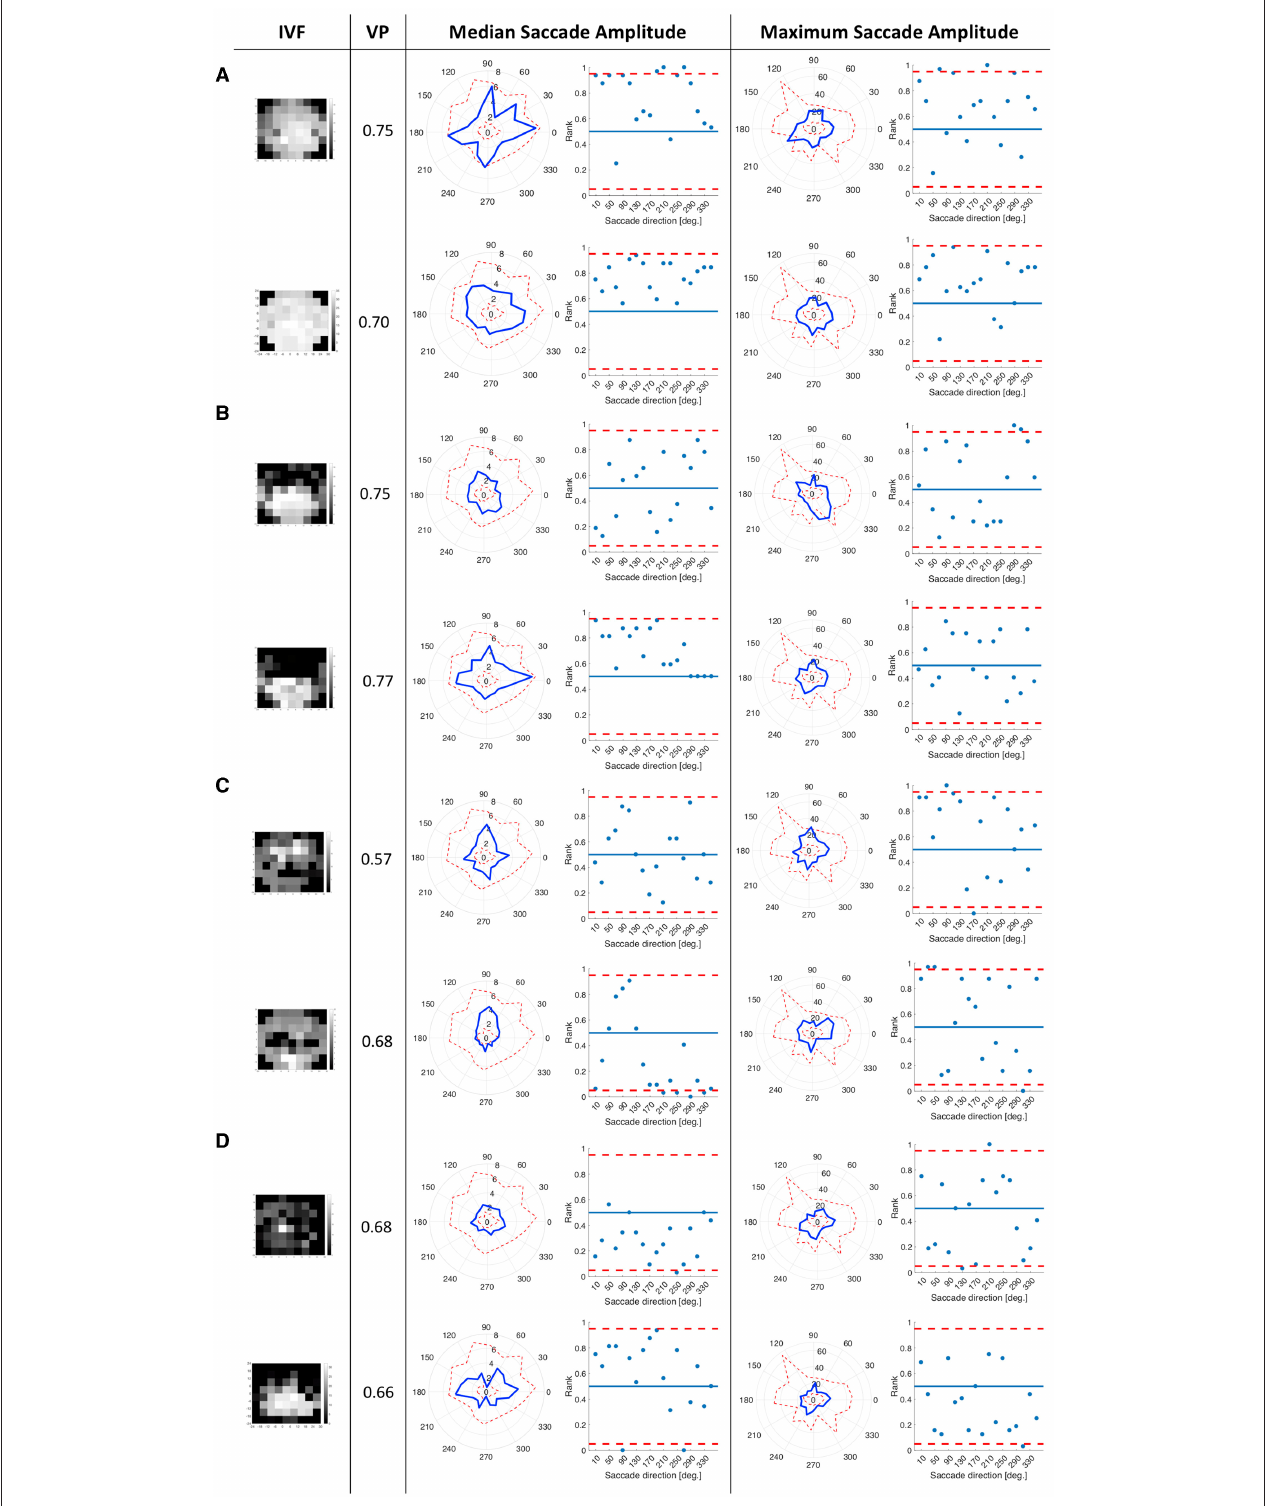
FIGURE 10 | The first figure shows the state of the IVF of each patient, with darker areas representing the less sensitive areas of the visual field. The second column shows the VP of this patient averaged across all trials that they performed. The third column shows the median saccade amplitudes in 18 directional bins of each patient, represented by the blue line. The range of the saccade amplitudes by the control group is represented by the scattered red line, showing the minimum and the